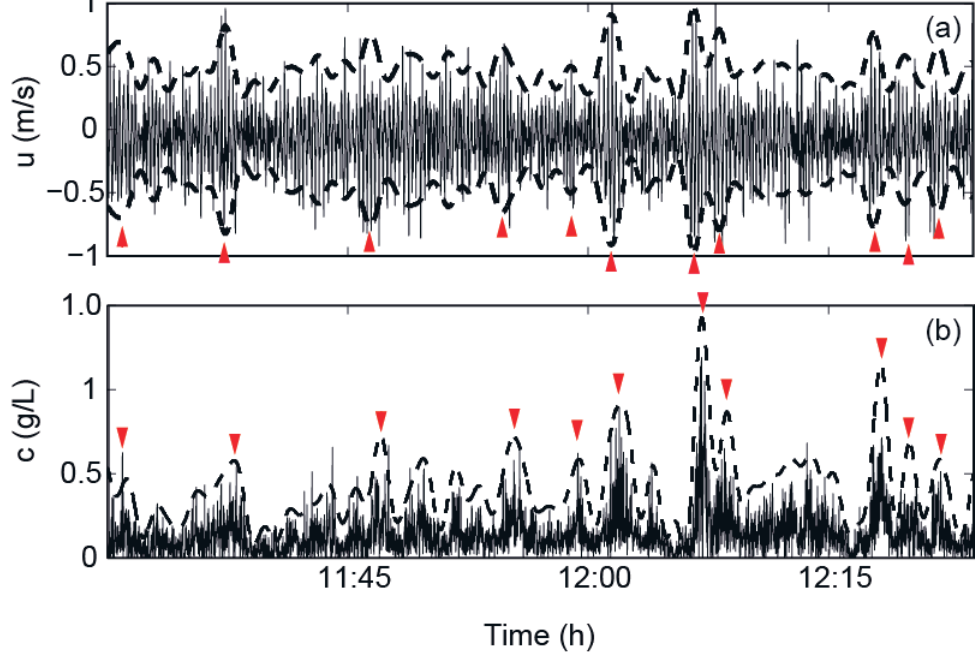
Figure 4. Time series of ( a ) cross-shore current velocity u ( z = 0.25 m; solid line) and the envelope function of u (thick, dashed lines); and ( b ) suspended sediment concentration c ( z = 0.05 m; solid line) and low-pass-filtered c (thick, dashed line) (shoaling waves over two-dimensional permanent post-vortex ripples, Cable Beach, Broome, Western Australia).